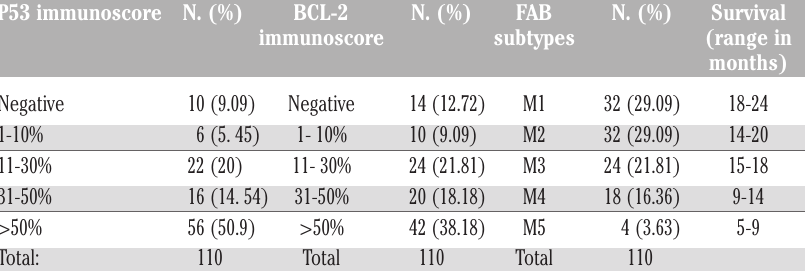
Table 2. P53 and BCL-2 immuno-scoring and survival data of AML